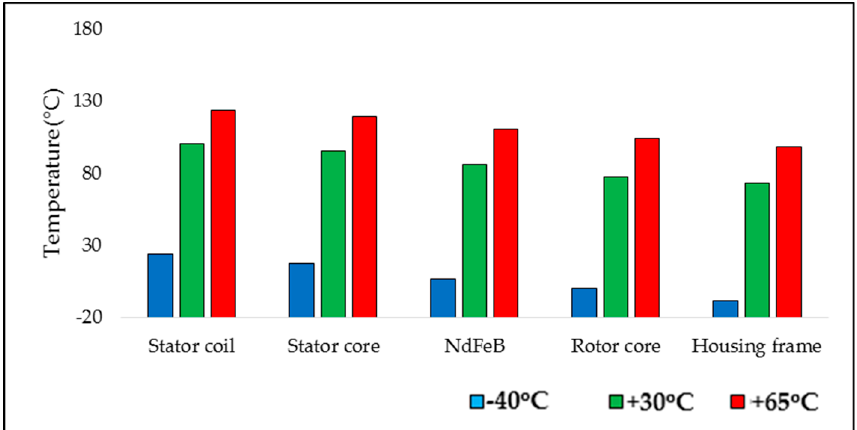
◦ C, + 30 ◦ C, + 65 ◦ C). Energies 2019 , 12 , x FOR PEER REVIEW 11 of 16